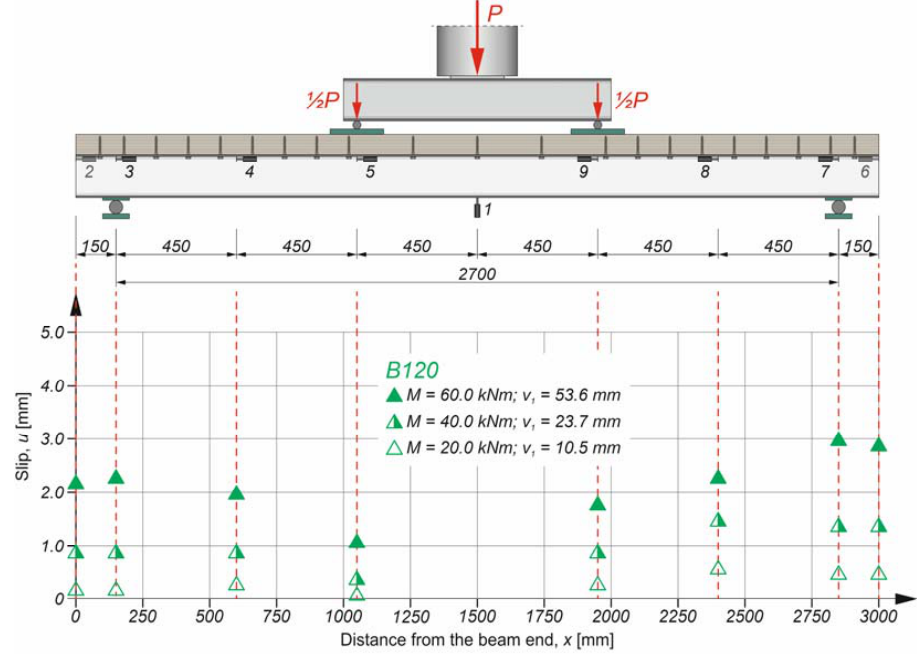
Appl. Sci. 2023 , 13 , 1603 Figure 8. Slip distribution in the B120 composite beam. Figure 8. Slip distribution in the B120 composite beam.